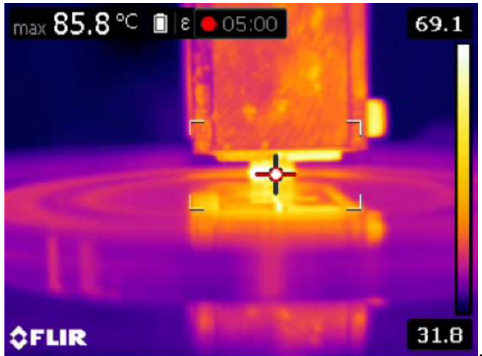
Figure 8. Temperature of the pure aluminium pin at 50 N loads at 5